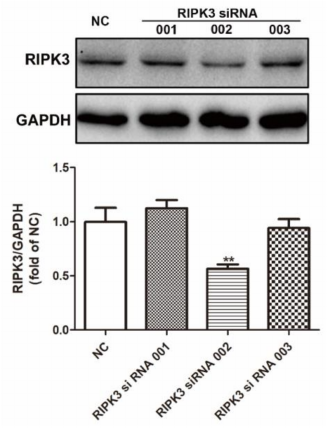
Figure 5. siRNA transfection downregulated RIPK3 expression in cardiomyocytes. Cardiomyocytes were transfected with NC siRNA or RIPK3 siRNA (001, 002, 003) for 4 h and cultured in DME/F-12 medium containing 10% FBS for 24 h. The expression of RIPK3 was detected by Western blot in cardiomyocytes. GAPDH was used as a loading control. Plots represent the mean ± SEM; n = 6. Statistical significance: ** p < 0.01 compared with NC.